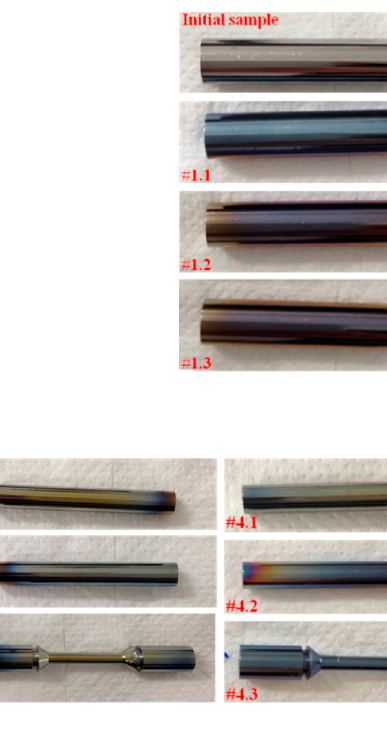
Figure 27. Titanium alloys after the extraction test.